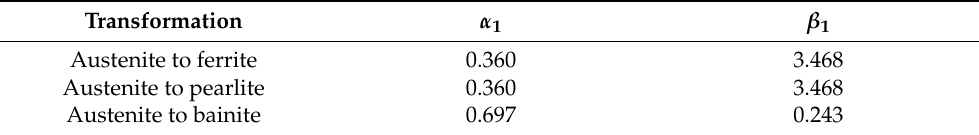
Table 1. Parameters used in diffusive phase